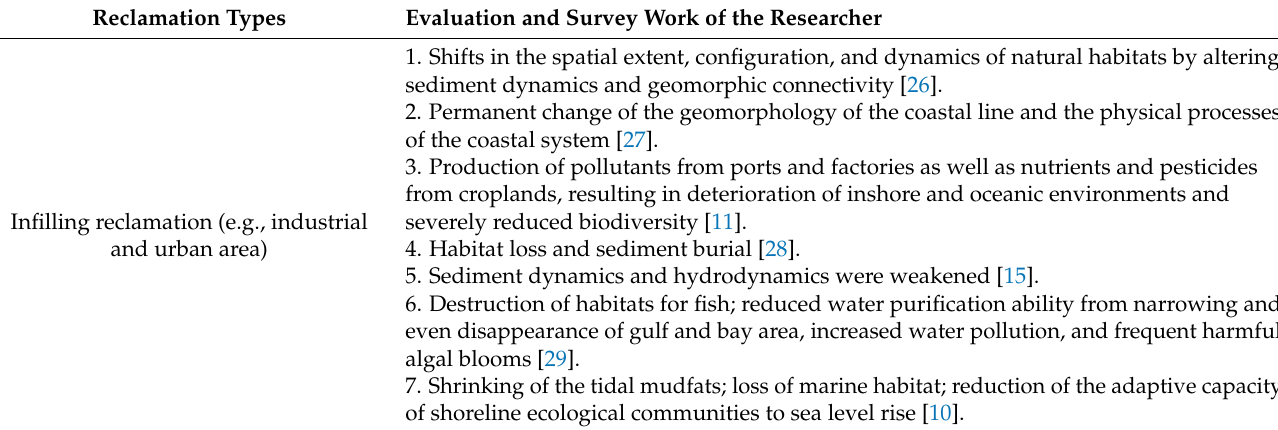
Figure 4. Assessment system of impacts of different reclamation types on the coastal ecosystem. Table 3. Supporting data for the reclamation impact intensity on the